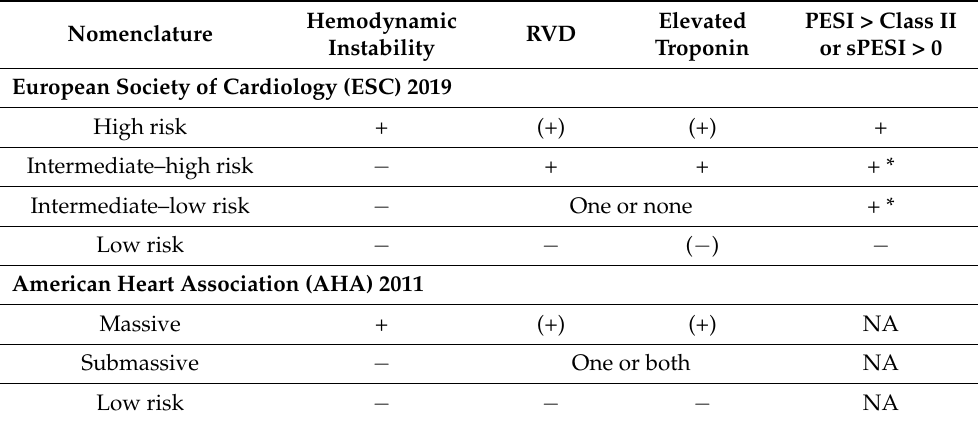
Table 1. Nomenclature in current European and American